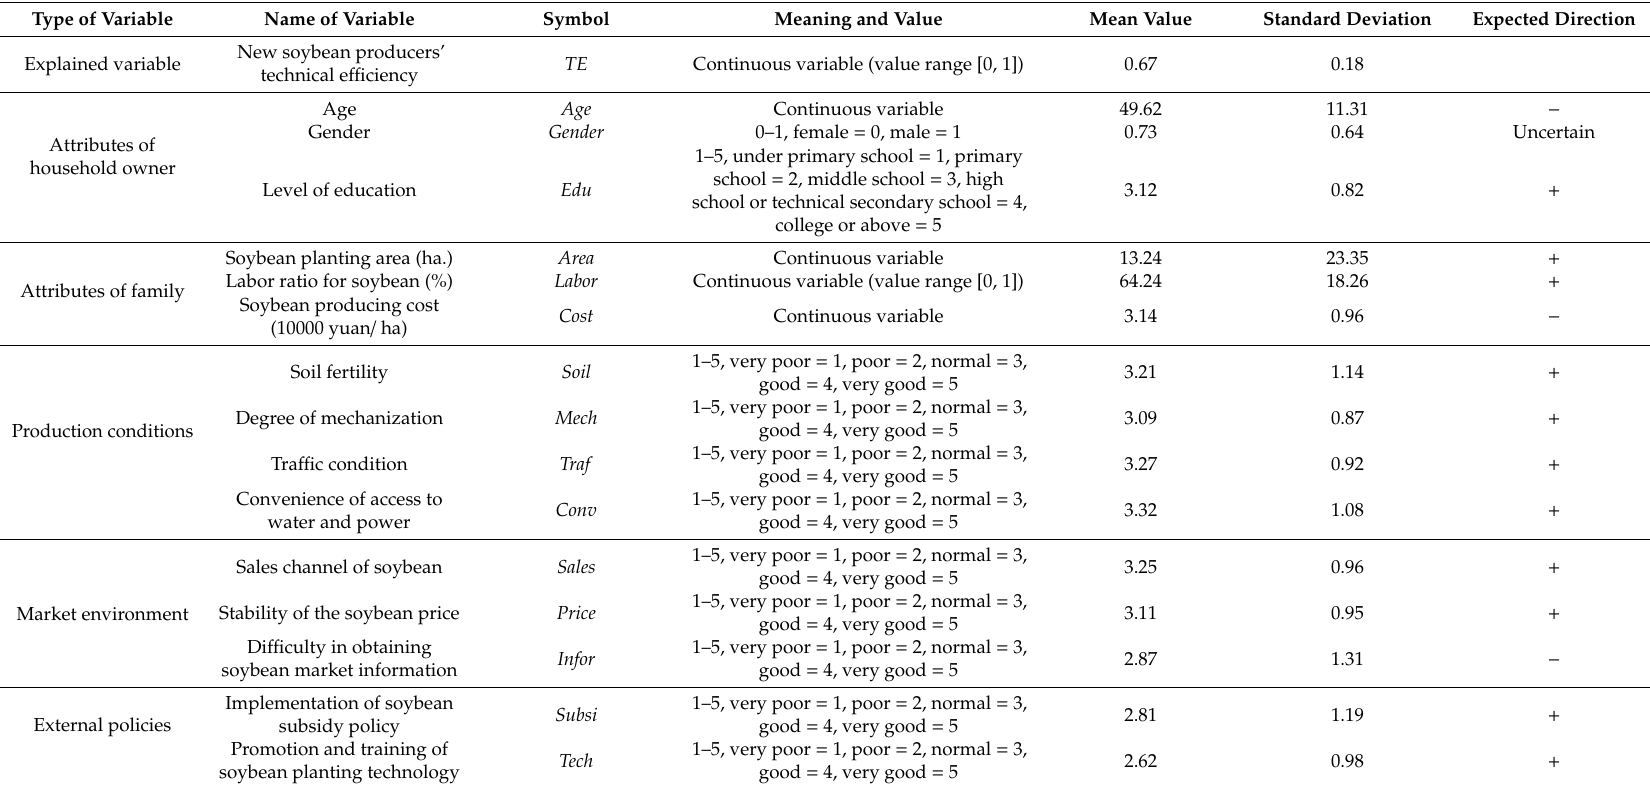
Table 5. Selection, interpretation, and descriptive statistics of variables in the Tobit